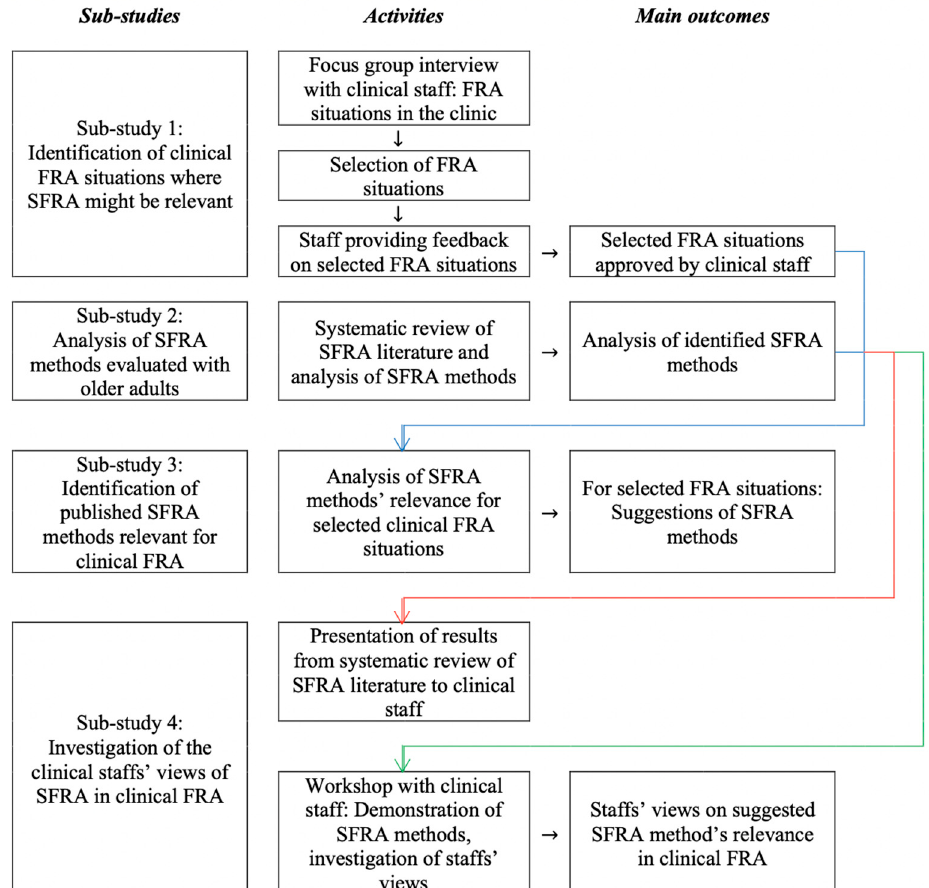
Figure 1. Overview of the study design including the four sub-studies, their related research activ- and main ities, and main outcomes.